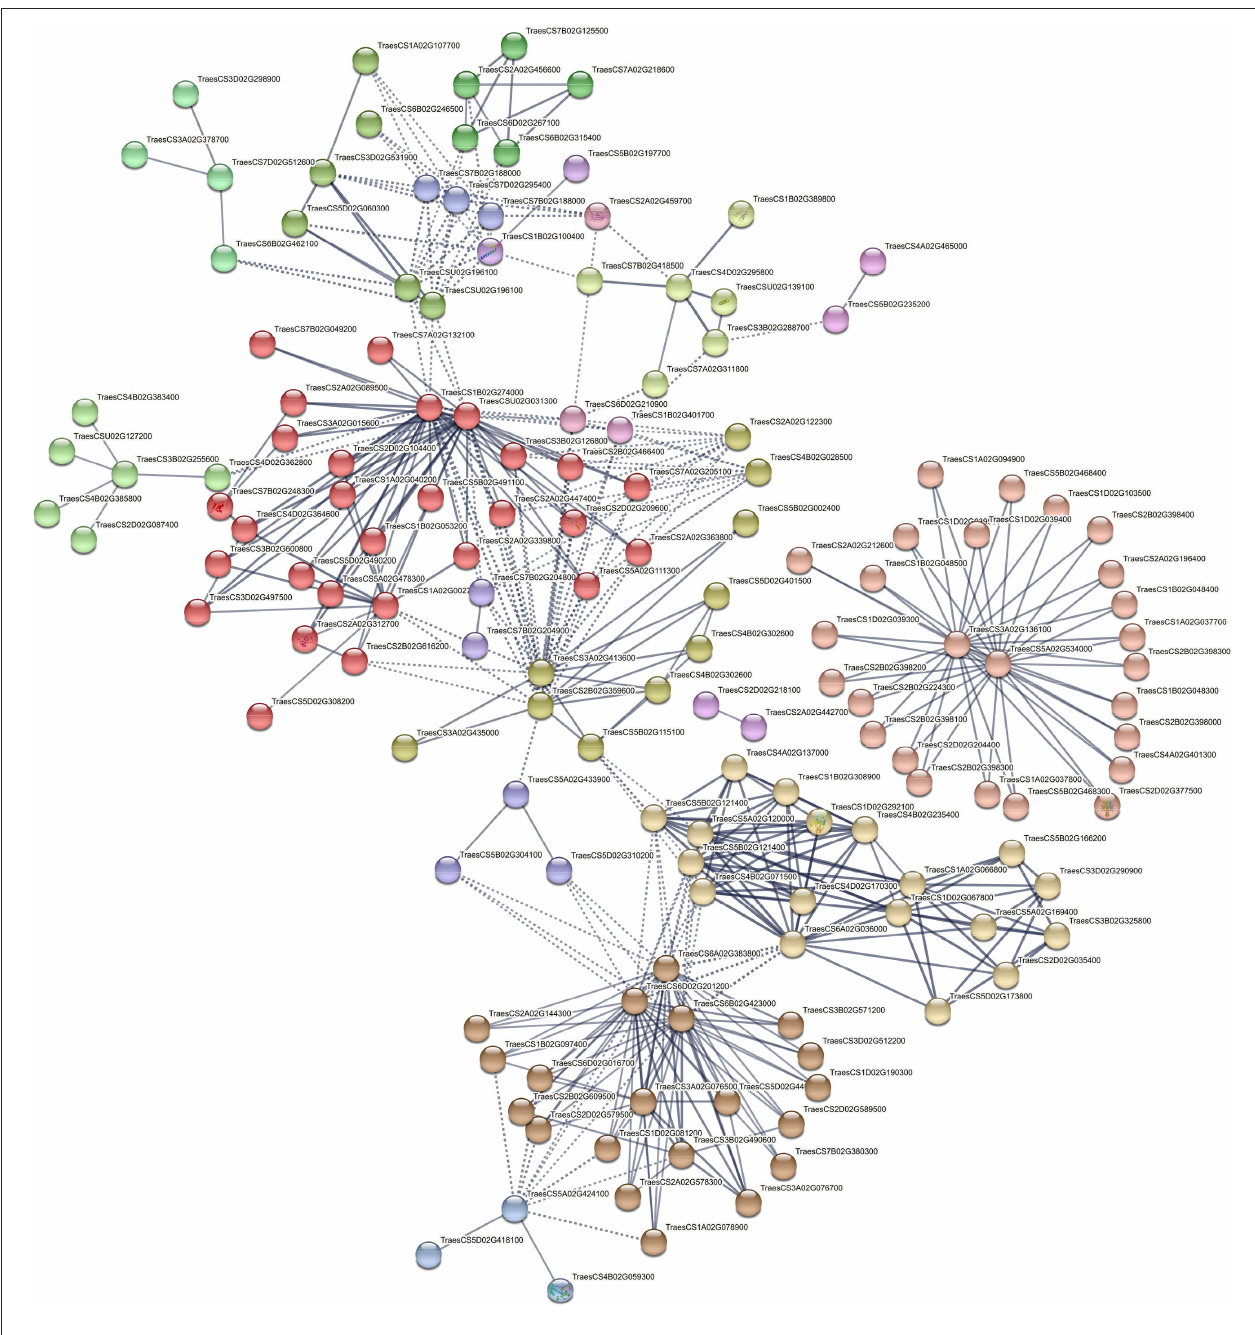
FIGURE 8 | Interaction networks of related DEGs in significant KEGG pathways and putative TFs identified by comparing PI627299 (T) vs. PI624837 (S). e.g., TraesCS2D02G377500 (Phenylalanine ammonia-lyase), TraesCS5B02G11510 (MADS-box transcription factor TaAGL31), TraesCS5D02G401500 (VRN-D1), TraesCS3B02G255600 (Heat shock factor C1e), TraesCS4B02G059300 (Glutathione S-transferase 1).